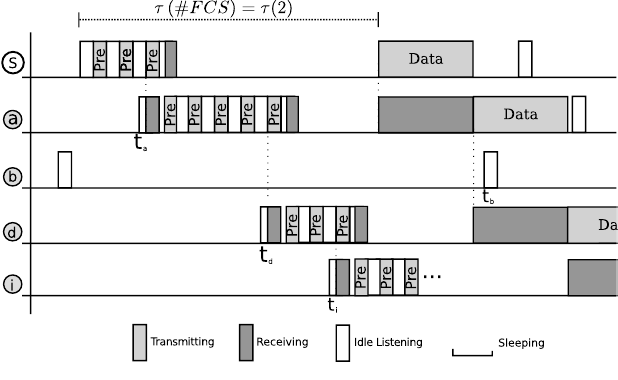
Figure 2. Overview of the PAX-MAC